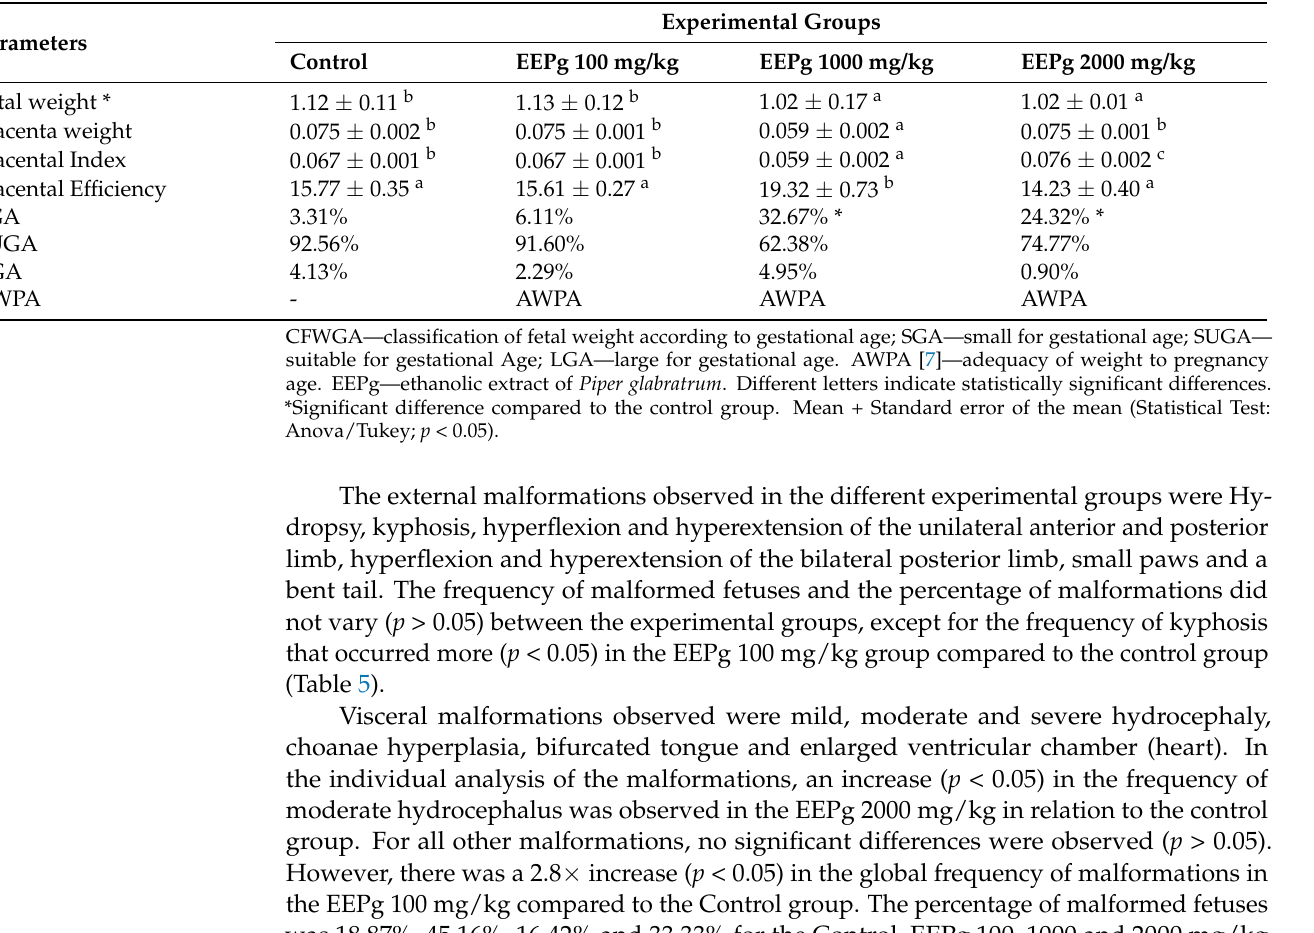
Table 4. Mean values ± standard error of mean parameters related to embryofetal development of females treated with ethanolic extract of P. glabratum